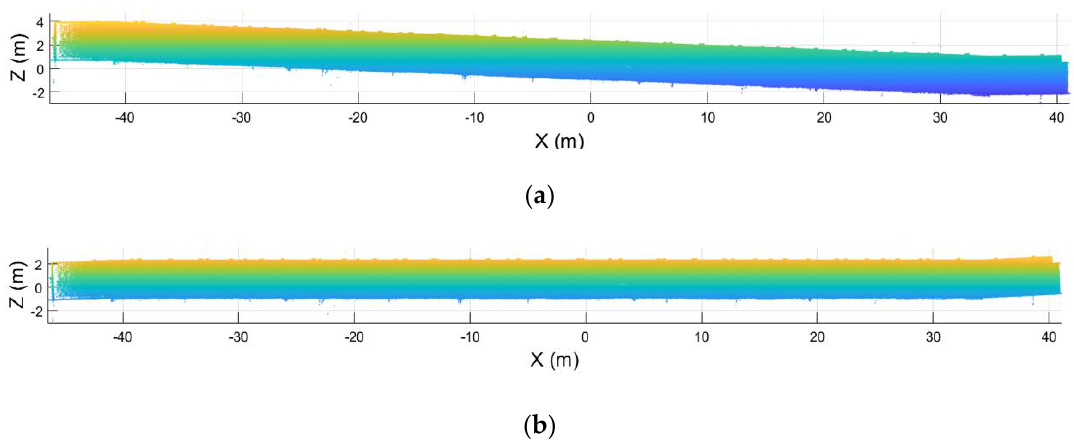
Figure 8. Point cloud leveled. ( a ) Point cloud before the leveling. ( b ) Point cloud after leveling.